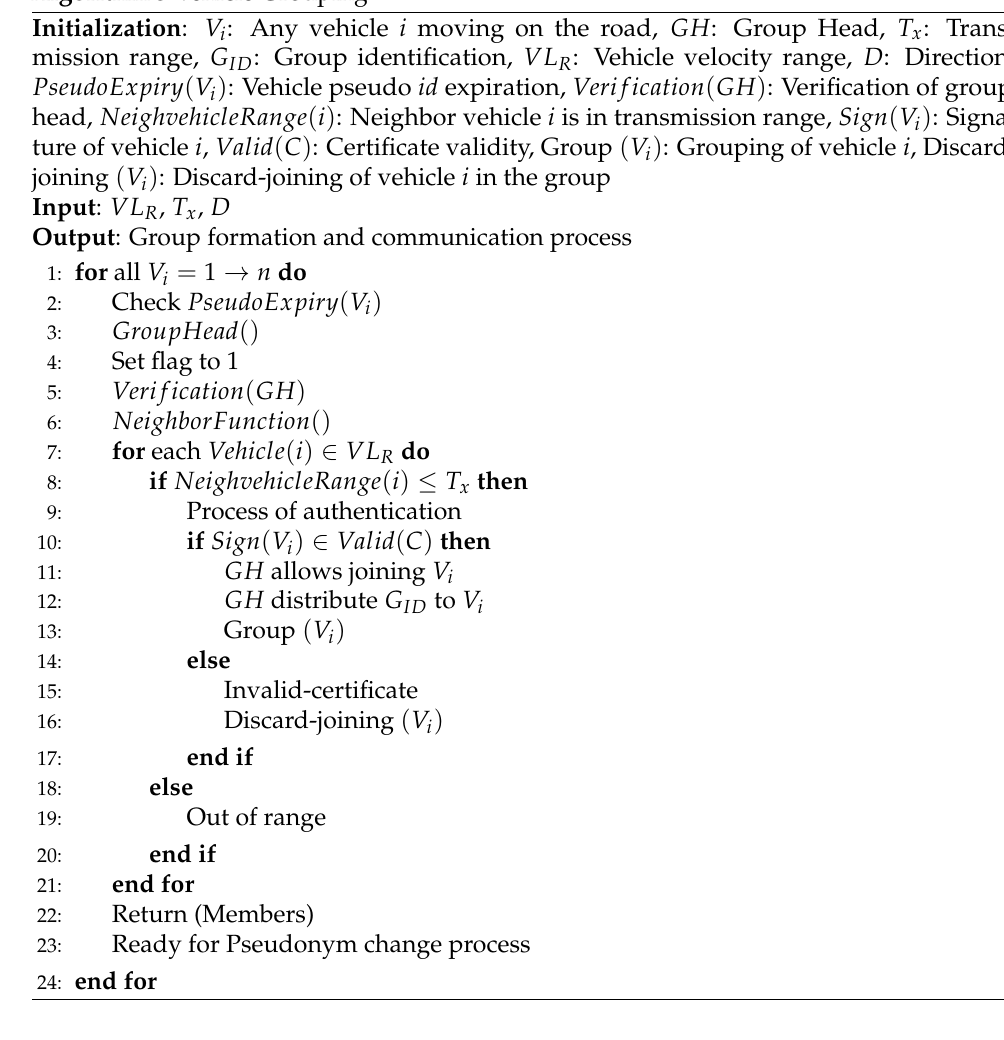
Algorithm 3 Vehicle